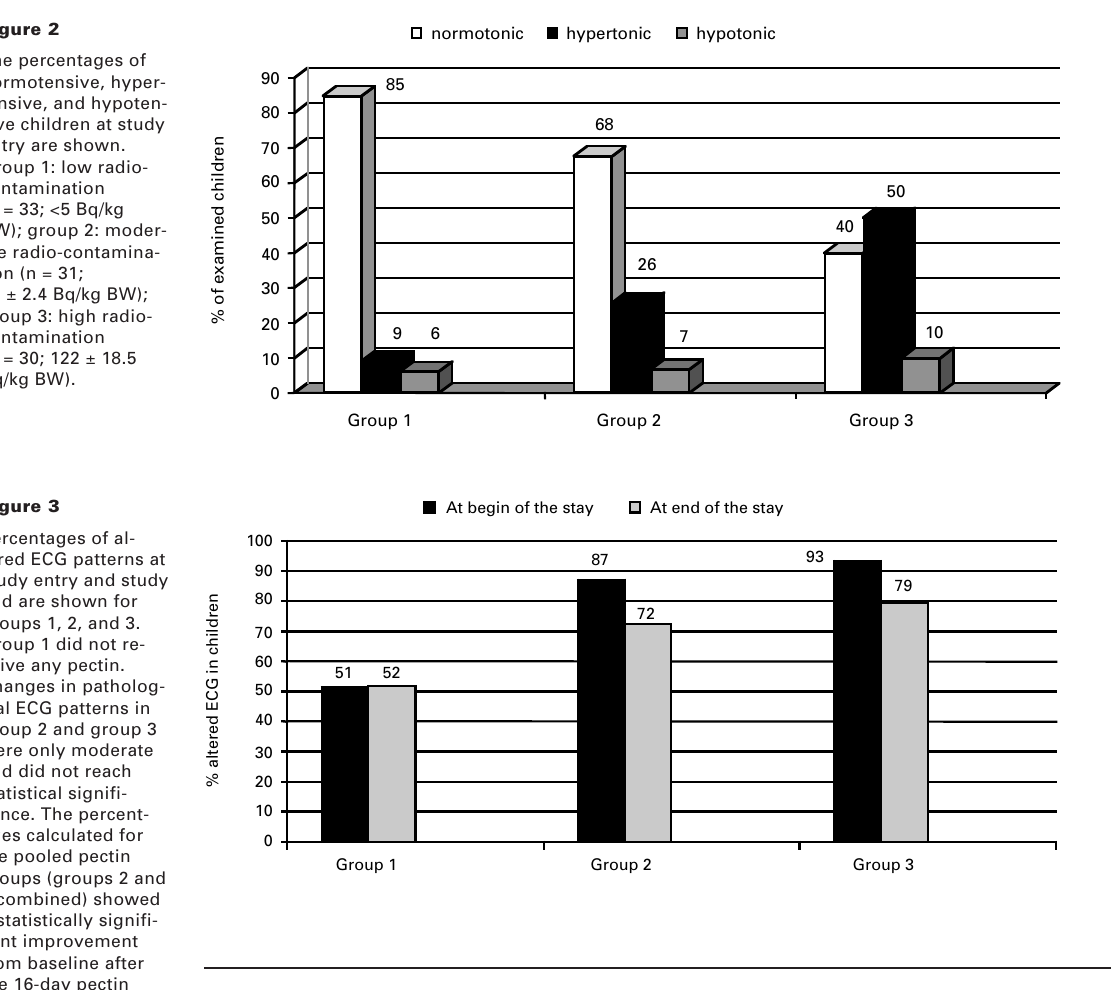
Figure 2 The percentages of normotensive, hyper- tensive, and hypoten- sive children at study entry are shown. Group 1: low radio- contamination (n = 33; <5 Bq/kg BW); group 2: moder- ate radio-contamina- tion (n = 31; 38 ± 2.4 Bq/kg BW); group 3: high radio- contamination (n = 30; 122 ± 18.5 Bq/kg